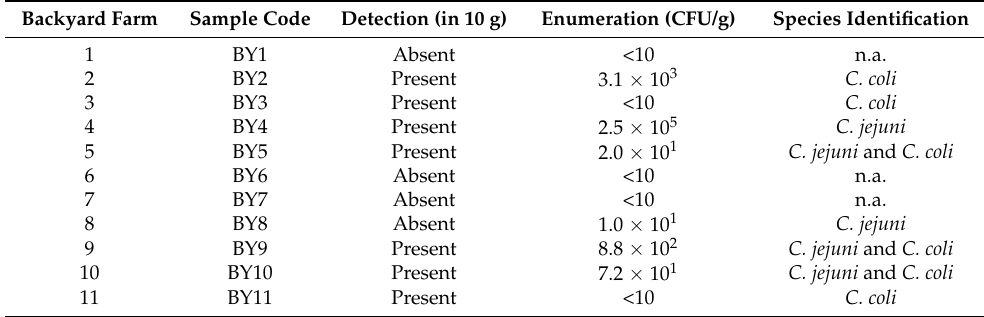
Table 2. Occurrence of Campylobacter spp. and levels of contamination of samples from the backyard production